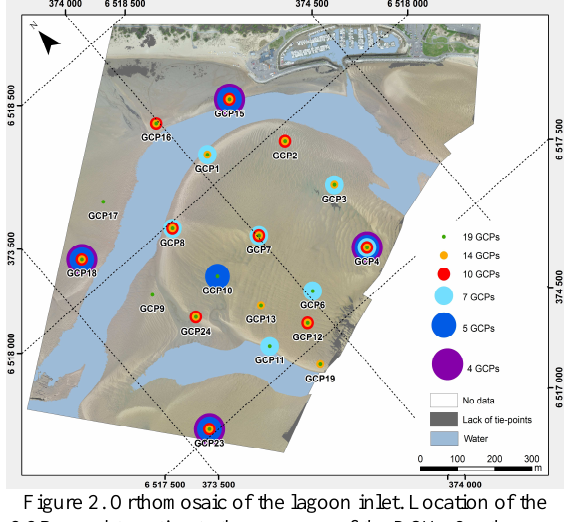
Figure 2. Orthomosaic of the lagoon inlet. Location of the GCPs used to estimate the accuracy of the DSM. On the grey areas the lack of tie-points doesn’t make possible photogrammetric processes. White areas correspond to no data. Ocean is located on the south of the study area The UAV is equipped of a CANON PowerShot ELPH110 HS RGB camera with a resolution of 16.1 MPixel. The characteristics of images are provided by the EXIF data (EXchangeable Image file Format) like the focal length (4.3 mm to21.5 mm), the shutter or the ISO values. So, for a flight height of 150 m, the ground sampling distance (GSD) will be 4.69 cm.